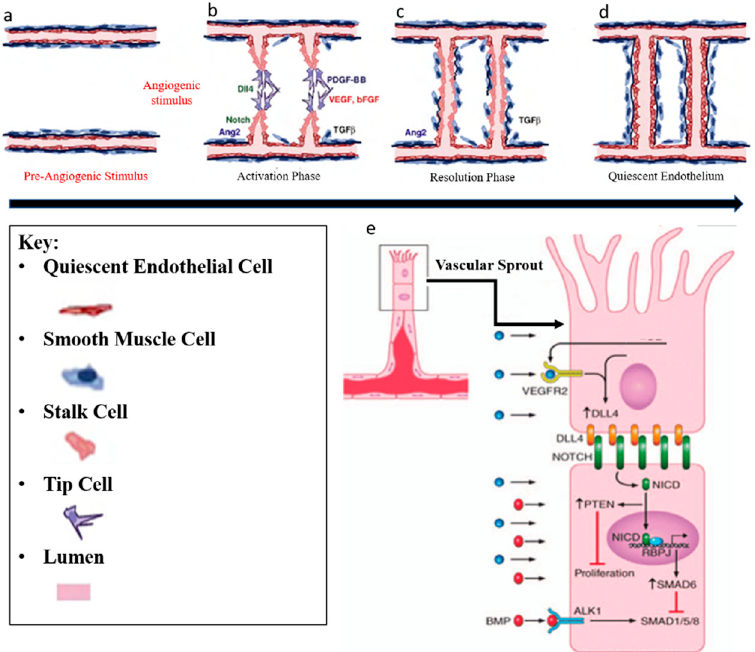
Figure 2. Angiogenesis regulation. Angiogenesis includes two phases. ( a ) In the activation phase, the basement membrane is degraded by angiogenic stimulus (VEGF, bFGF, and TGF-ß) ( b ) and tip cells invade the tissue by extending filopodia. Stalk cells proliferate and extend, and new branches join in tip-cell-tip-cell fusion. ( c ) Lastly, in the resolution phase, endothelial cells (ECs) stop proliferating and mature by re-formation of basement membrane ( d ) and obtain a quiescent phenotype which is called phalanx EC. Illustration with permission from [37]. ( e ) VEGF signalling induces Dll4 expression in tip cells and consecutively, Dll4 activates Notch signalling in stalk cells. This results in reducing stalk-cell sensitivity to VEGF stimulation, which in turn suppresses the tip cell phenotype. Illustration with permission from [39].